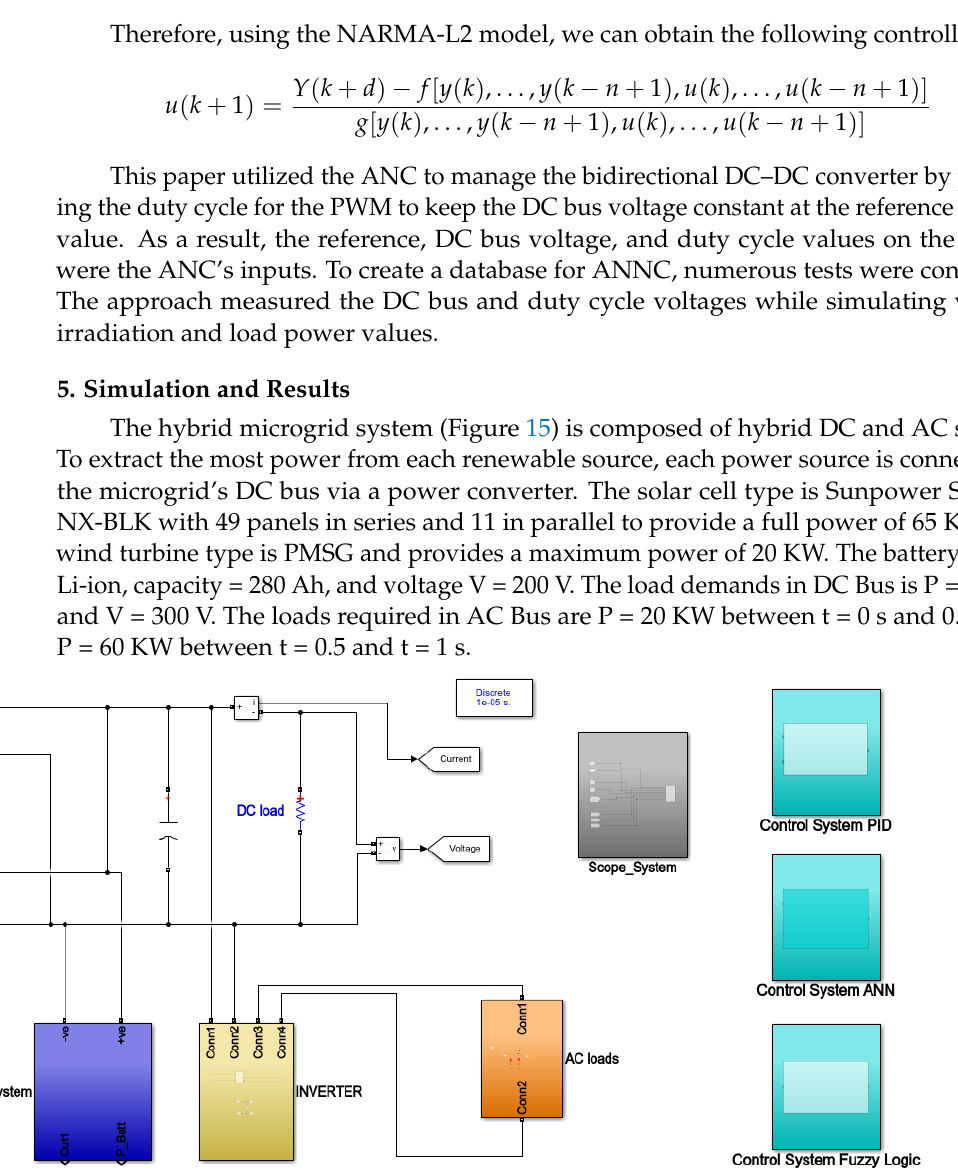
Figure 15. Simulink file of the proposed EMS with multiple controllers.